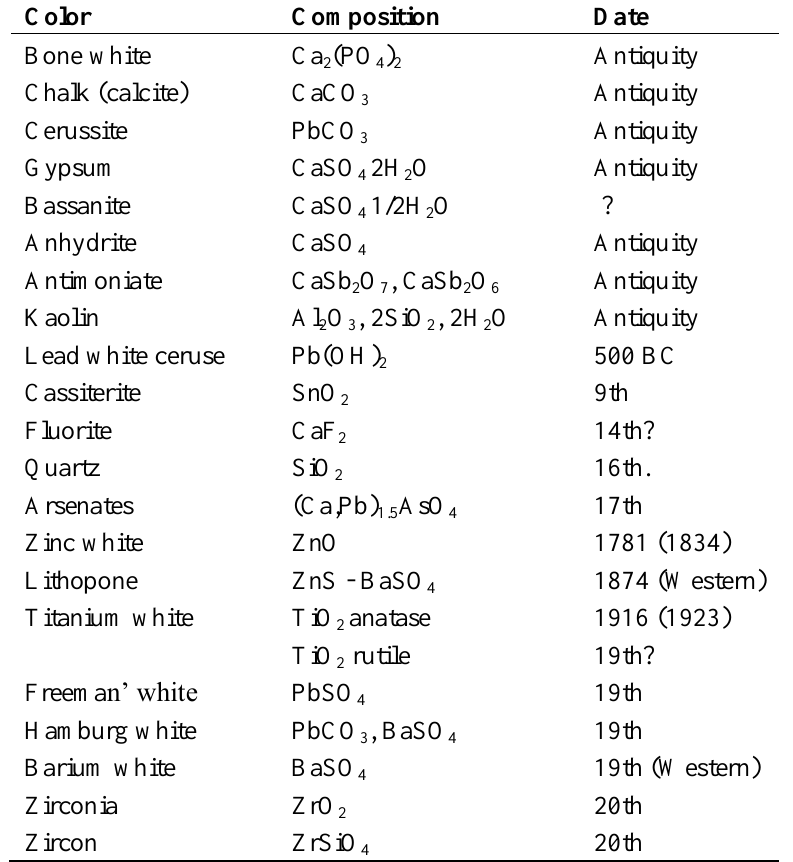
Table 1. White pigments and opacifiers. Dates of innovation (first production) are given.